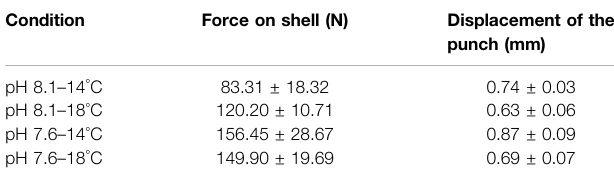
TABLE 1 | Maximum values for the behavior of shells in the fl exo-compression test. Mean and standard error of force and